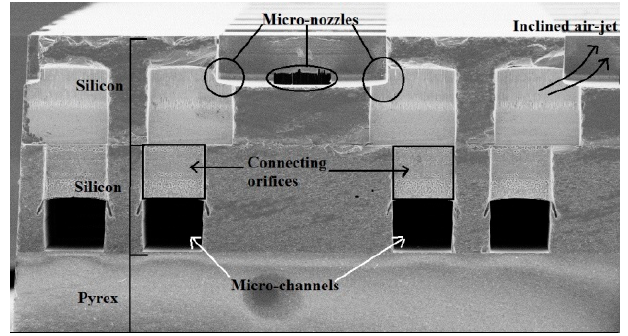
Figure 3. Cross-section view of the wafers (East–West nozzles).